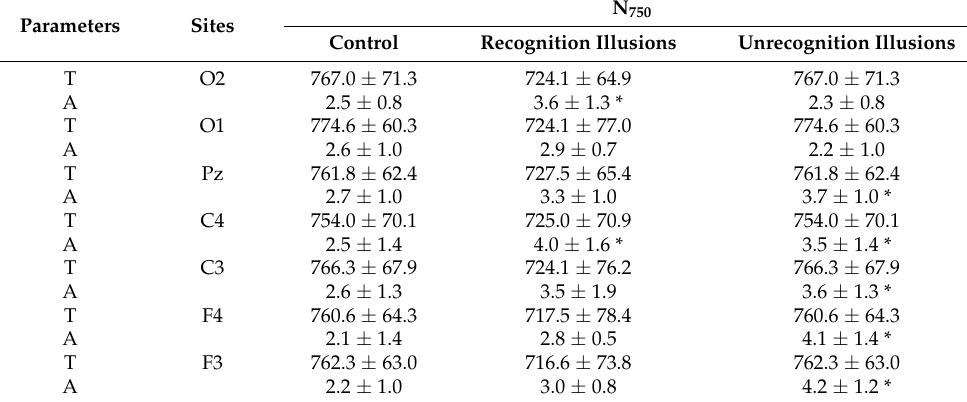
Table 5. Amplitude (A, uV) and time (T, ms) characteristics of the component N 750 ERP.